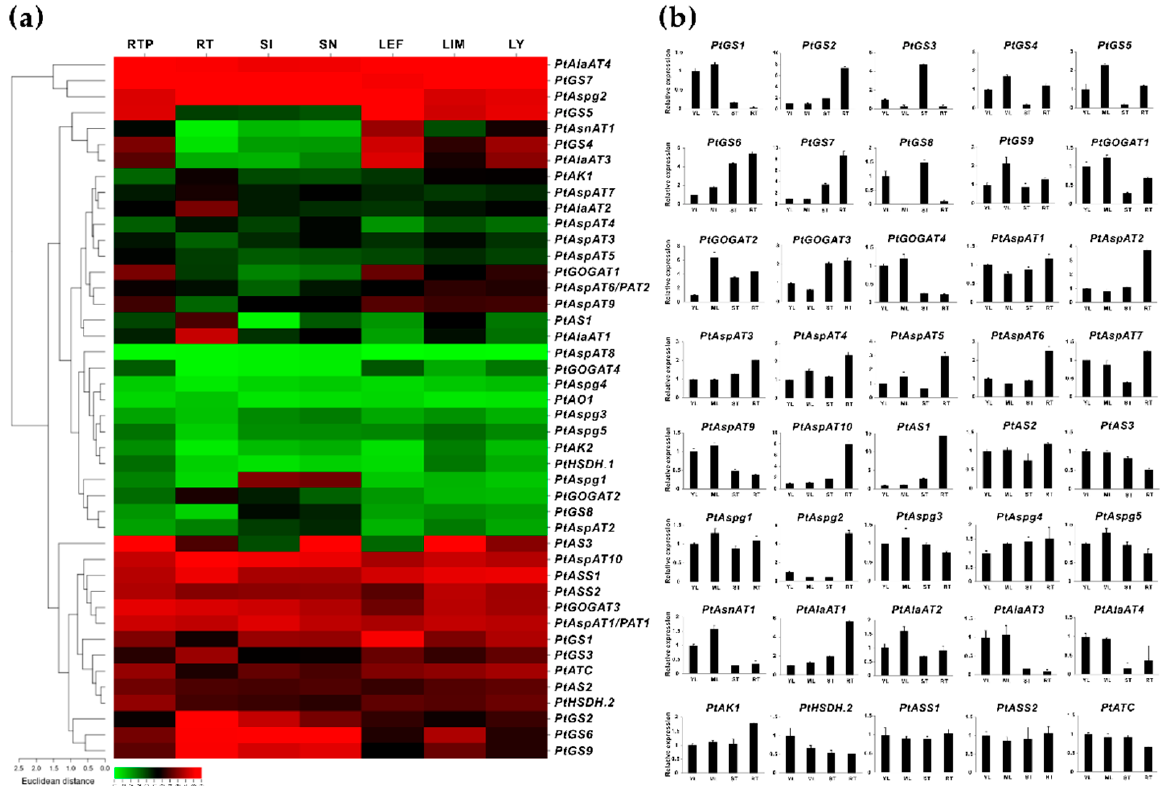
Figure 3. Transcriptomic and expression profiles of isogenes involved in Asp metabolic pathways in various tissues of P. trichocarpa . ( a ) The heatmap shows the transcript in vegetative tissues. ( b ) The qRT-PCR evaluation shows the tissue-specific expression. The RNA-seq results were given in the Log of the fragments per kilobase per million reads (FPKM) expression values. At least three independent biological replicates were conducted for qRT-PCR analyses. PtActin , PtUBIC , and PtEF- α 1 were used as the internal